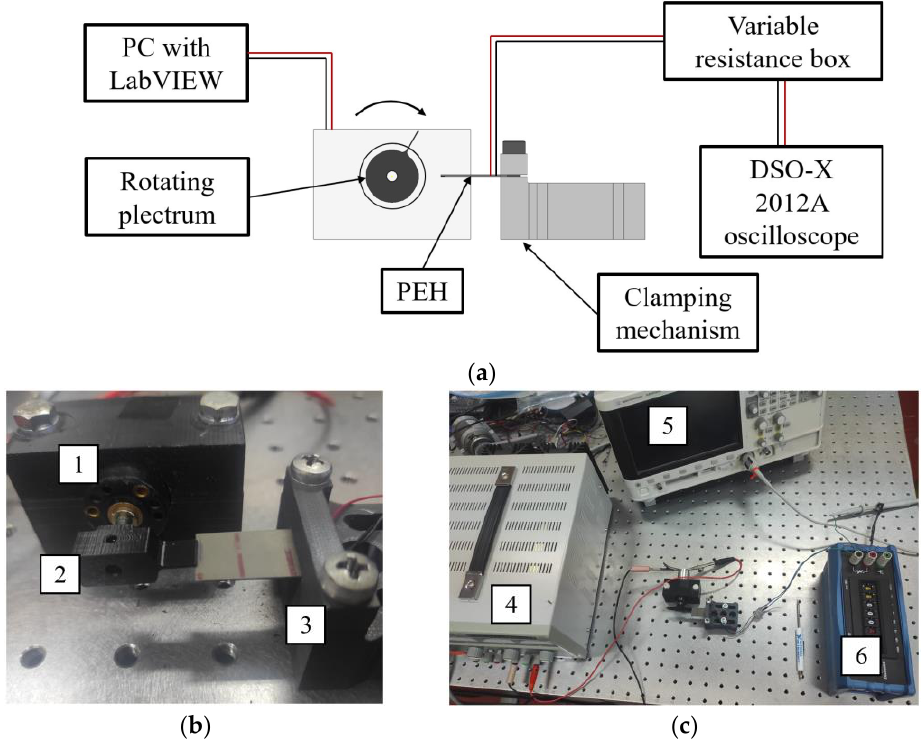
Figure 3. Experimental setup for plucking FUC PEH excitation: ( a ) schematic representation [14], ( b ) close-up of its actual execution showing the DC motor (1), the rotor with the plectrum (2) and the clamping mechanism with a PEH (3) and ( c ) the overall setup with the motor power supply (4), the oscilloscope (5) and the resistance box simulating the electrical load (6).